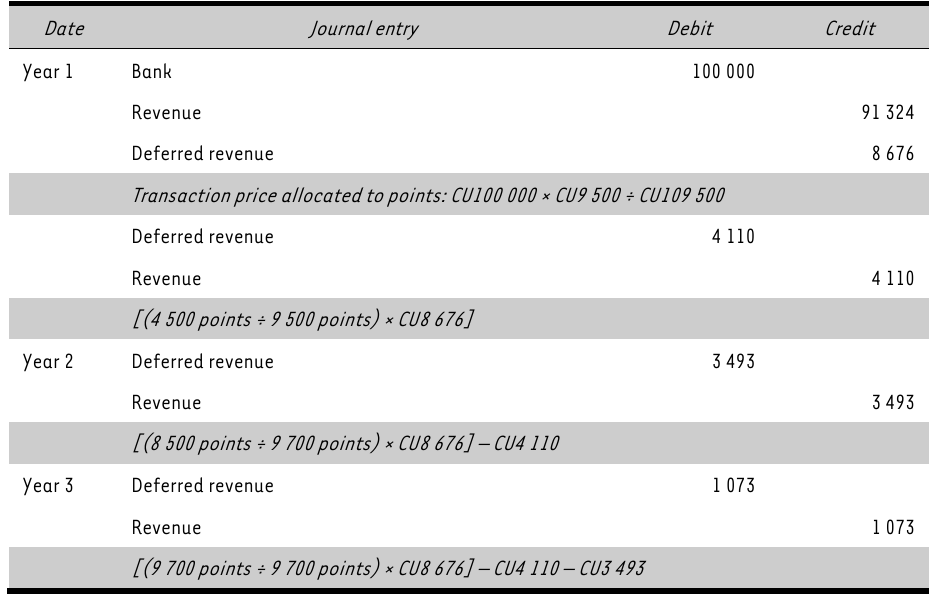
TABLE 3: General journal entries of the client loyalty programme